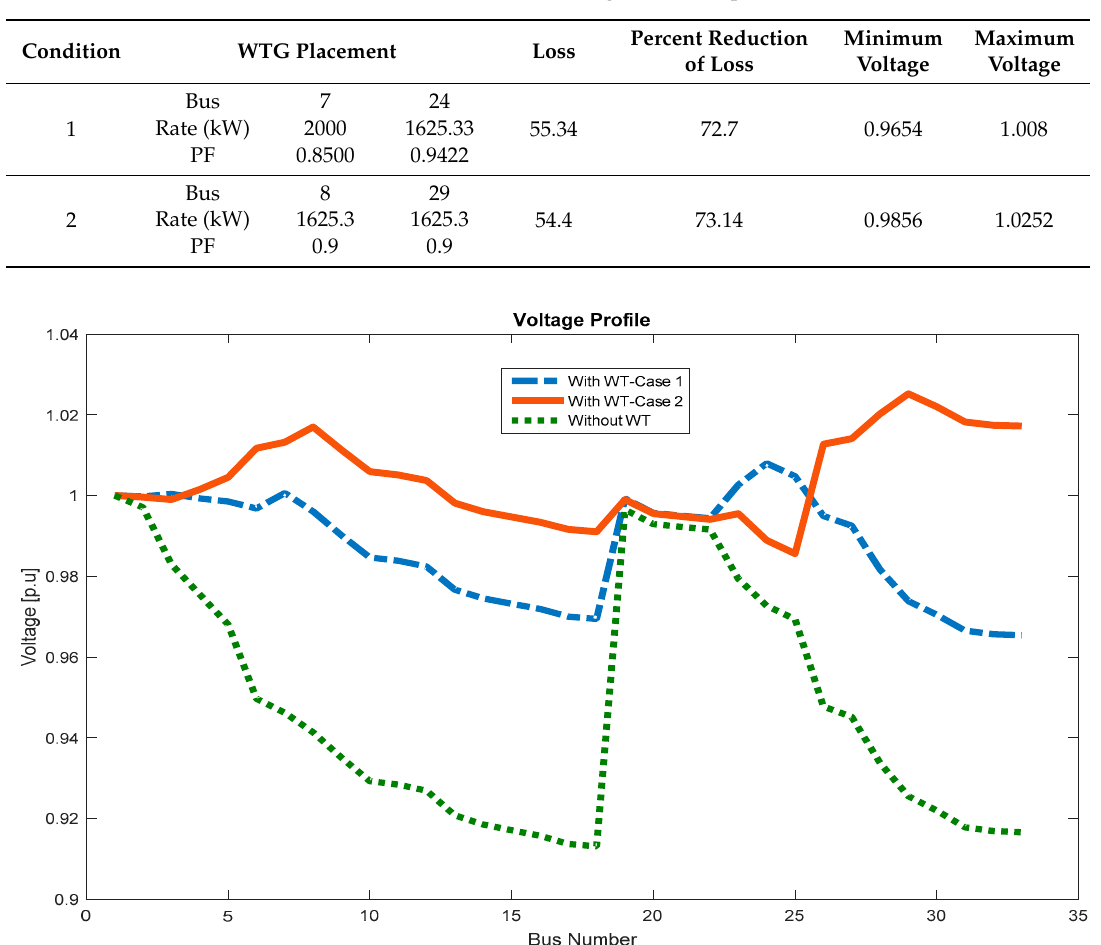
Table 6. Results of site selection for 32-bus grid with respect to constraints.